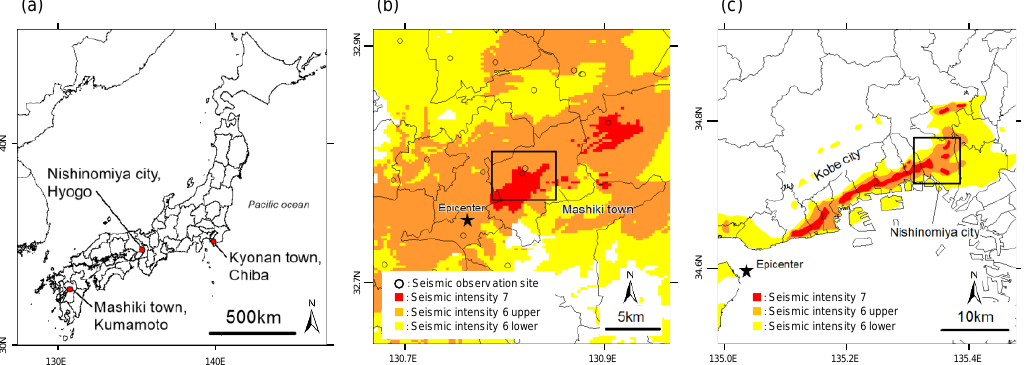
Figure 1. ( a ) Locations of the target areas of this study. ( b ) Seismic intensity map of the Kumamoto earthquake on 16 April 2016 [28], in and around Mashiki town, Kumamoto prefecture. ( c ) Seismic intensity map of the 1995 Kobe earthquake [29], in and around Nishinomiya city, Hyogo prefecture. Rectangle in ( b ) and ( c ) indicates the areas of interest.